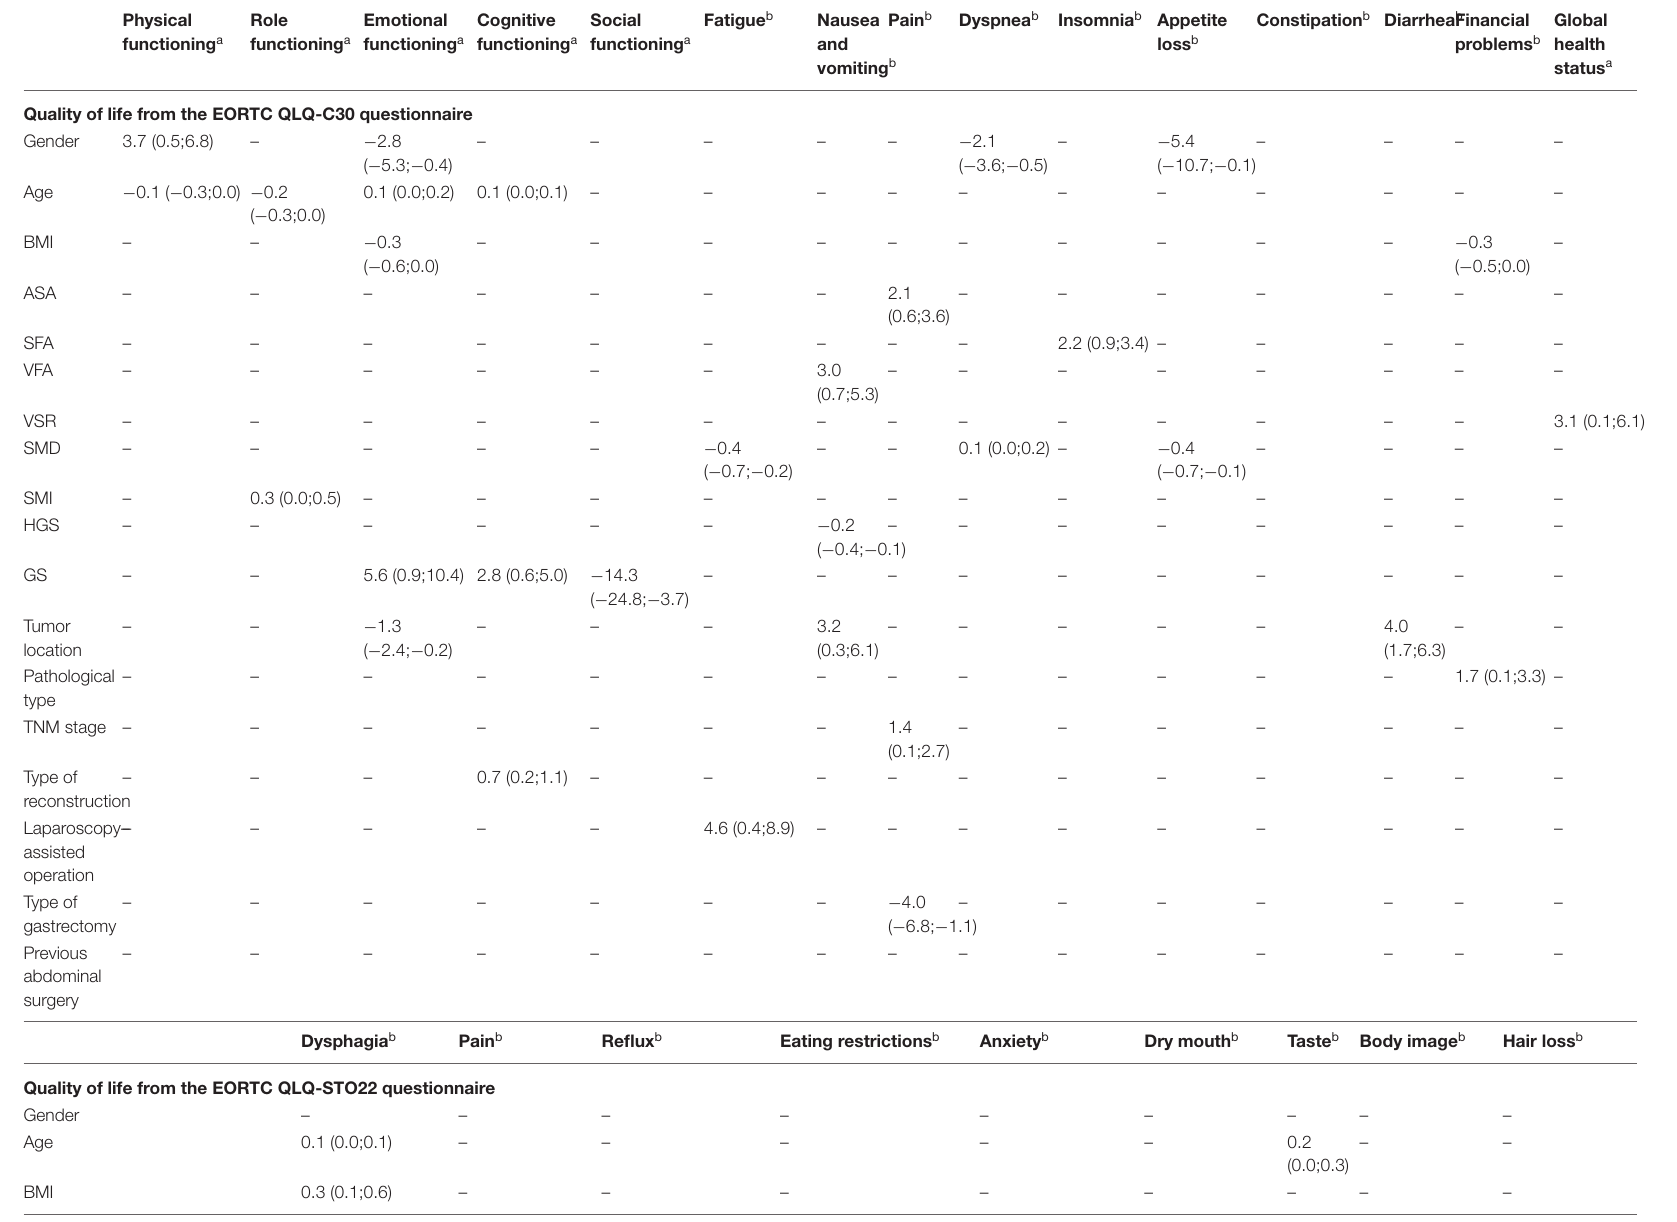
TABLE 5 | Multivariable linear regression model on quality of life, symptom scales, and functional scales from EORTC QLQ-C30 and QLQ-STO22 for 6 months after